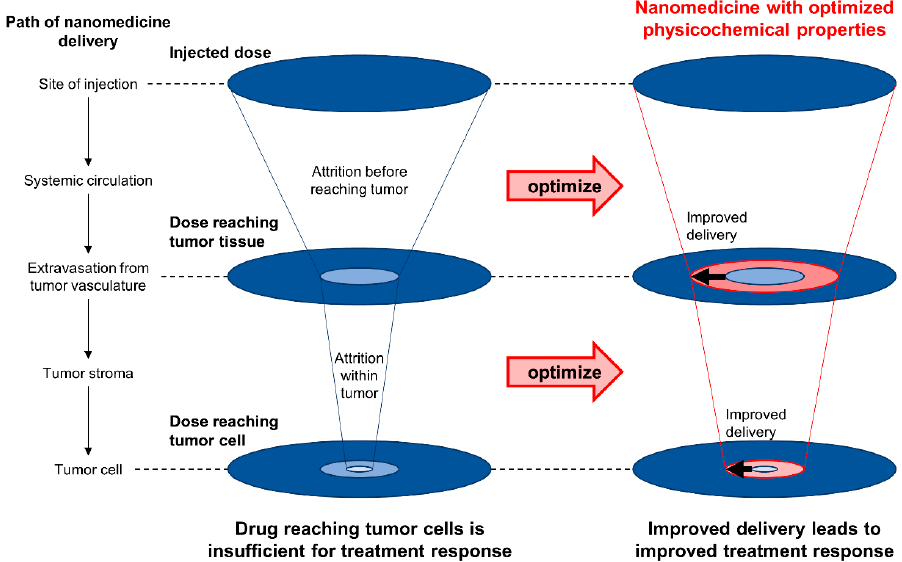
Figure 9. Optimizing physicochemical properties of nanomedicine to improve delivery and treatment response. A significant amount of the injected nanomedicine is lost before it reaches the tumor cells to elicit a therapeutic effect. By optimizing the physicochemical properties of nanomedicine such as particle size, particle geometry, surface charge, surface chemistry, and elasticity, the efficiency of nanomedicine delivery can be improved. Optimization must not only address attrition due to fibrotic barriers but also attrition even before the nanomedicine reaches the tumor tissue.